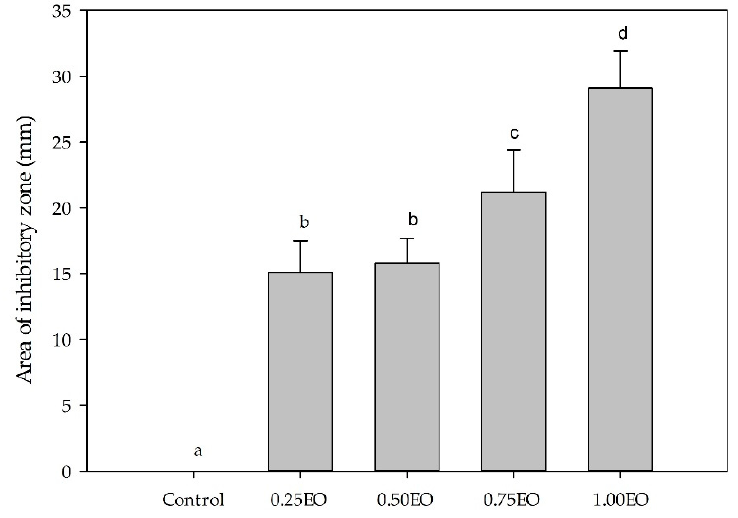
Figure 3. Antimicrobial activity (mm) of chitosan films with Citrus limonia essential oil against Staphylococcus aureus. a,b,c,d Di ff erent letters in the same column indicate significant di ff erence by Tukey’s test ( p ≤